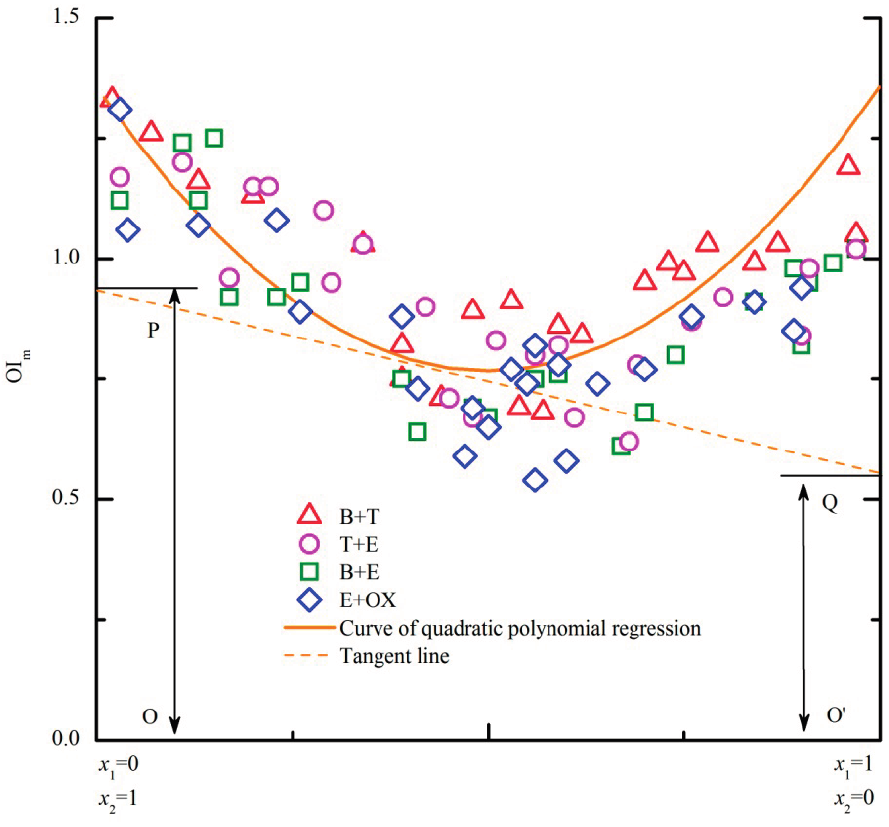
Figure 3. An extended PDE model for any binary odor mixture of benzene and substituted benzenes. Equation of the fitting curve (solid line) was y = 2.36 x 2 − =2.36 x + 1.36. The dashed line was a tangent line to the curve at the given point (0.4, 0.8). Value of the (or OI intercept O’Q (or OP) equaled to OI 1,m 2,m